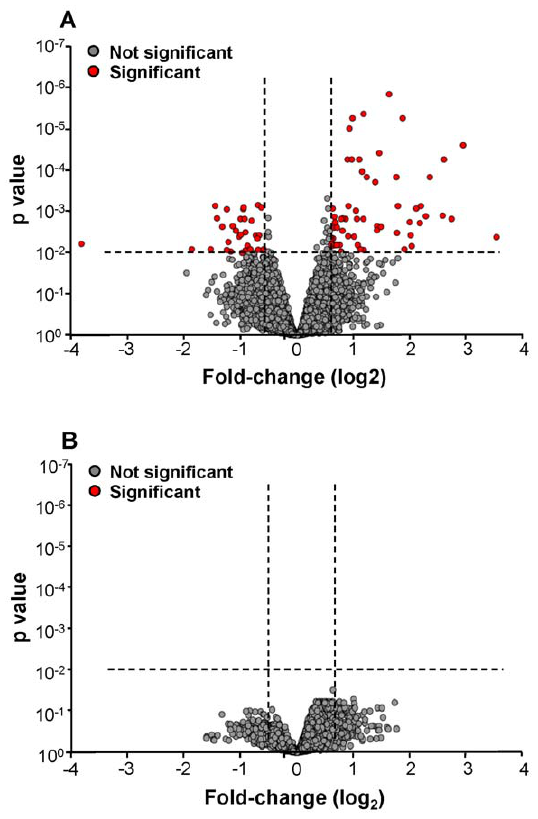
Figure 4. Genome-wide gene expression in the small airway epithelium of COPD smokers (n = 22) vs high and low responder subgroups of healthy smokers (n=29 in each group). A. Volcano plot of COPD smokers vs low responder healthy smokers. The mean expression level for COPD smokers vs low responder healthy smokers was assessed for fold-change (abscissa) vs p value (ordinate) by t-test. Each probe set is represented by a filled circle, with probe sets that are not significantly different in COPD smokers compared to low responder healthy smokers in gray and those that are significantly different in the 2 groups in red. Probe sets with a higher expression level in COPD smokers are to the top right and those with a lower expression level in COPD smokers are to the top left. There are 92 probe sets representing 75 known genes that are significantly up- and down-regulated in COPD smokers vs low responder healthy smokers. B. Volcano plot of COPD smokers vs high responder healthy smokers. The mean expression level for COPD smokers vs high responder healthy smokers was assessed for fold-change (abscissa) vs p value (ordinate) by t-test. Probe sets that are not significantly different in COPD smokers compared to high responder healthy smokers are shown in gray and those that are significantly different in the 2 groups in red. Probe sets with a higher expression level in COPD smokers are to the top right and those with a lower expression level in COPD smokers are to the top left. Genome-wide, no probe sets were significantly different in COPD smokers compared to high responder healthy smokers. independent test set of COPD smokers (n = 14) compared to high responder smokers (n= 5) and low responder smokers (n= 5). While this test set had reduced power compared to the larger primary set, consistent with the data from the primary set, there were no expression differences between the COPD smokers and high responder healthy smokers, whereas 18 probe sets represent- ing 16 genes were differentially expressed between COPD smokers and low responder healthy smokers.